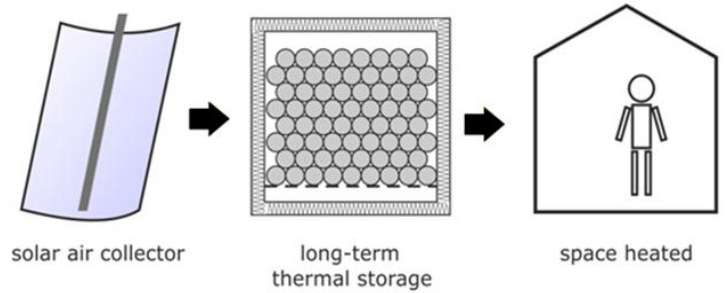
Figure 1. The concept of a solar heating system.